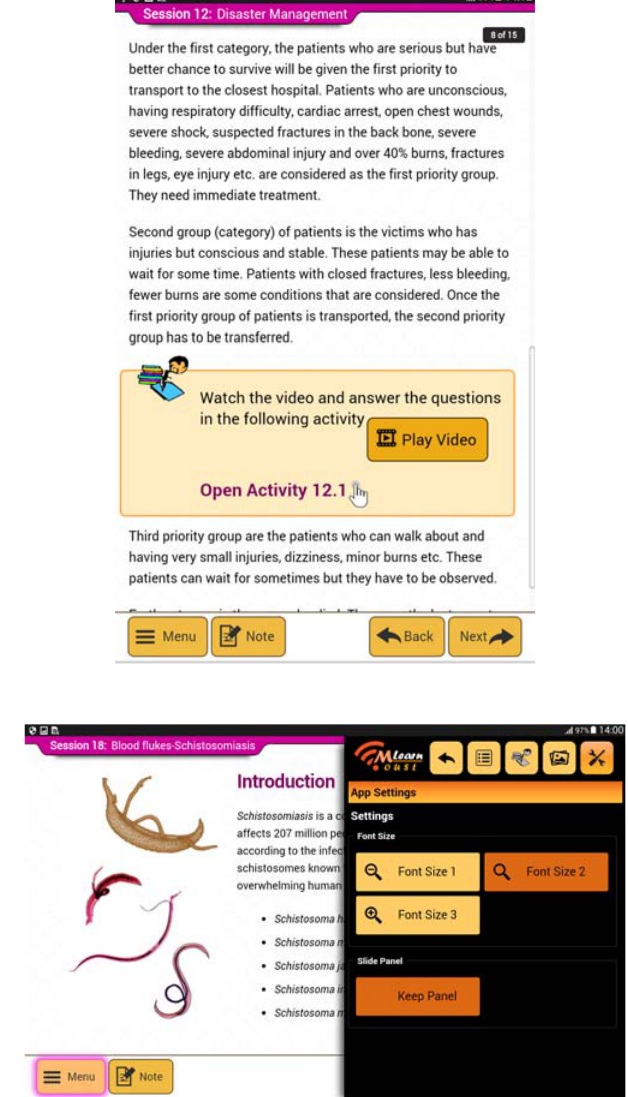
Figure 7. Flexibility of using different font